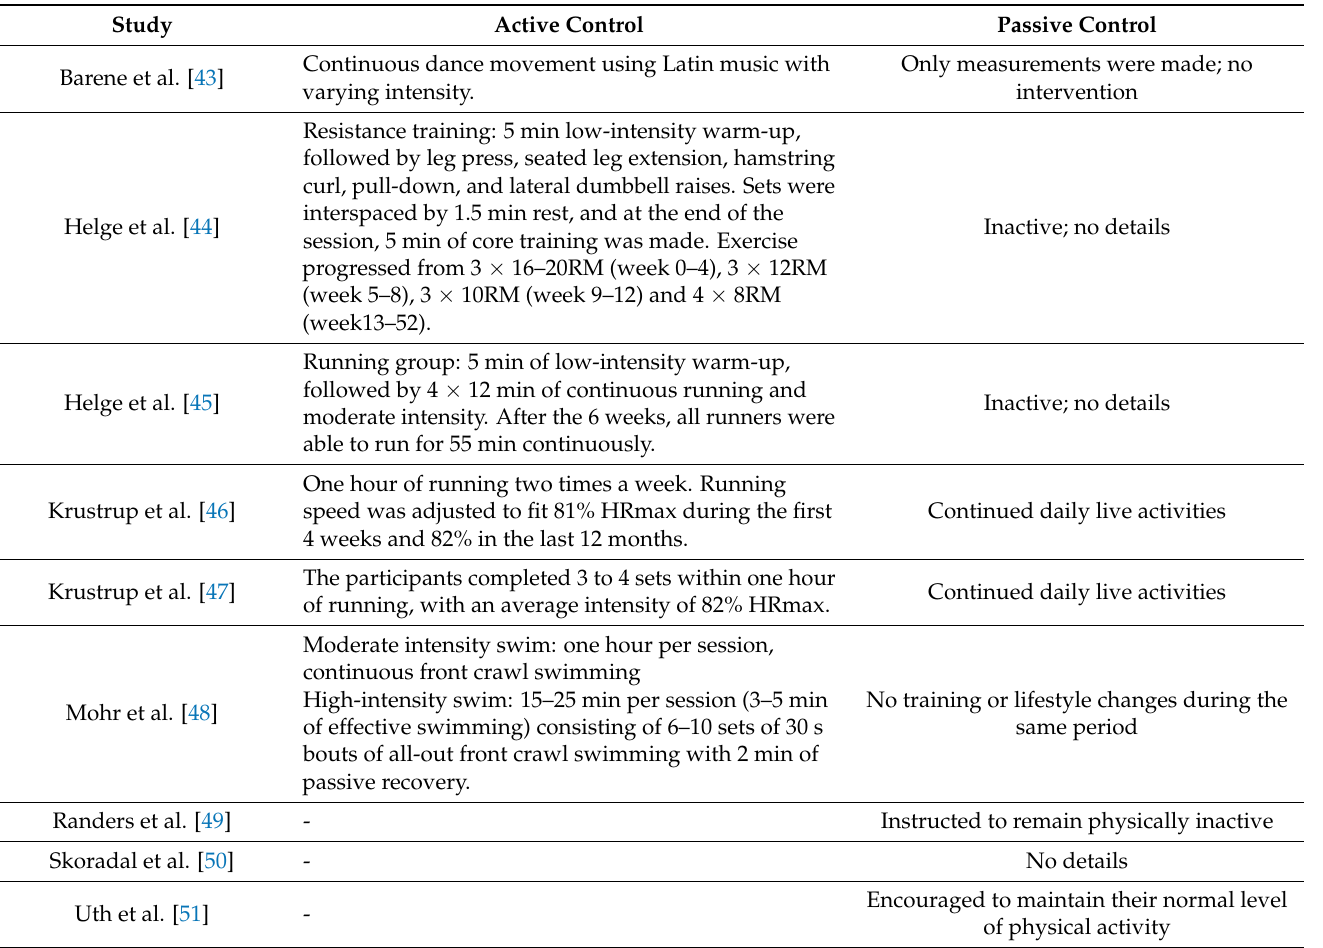
Table 4. Characteristics of control